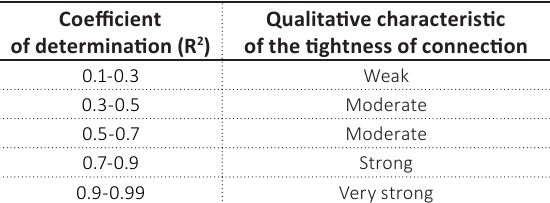
Table 1. Chaddock’s